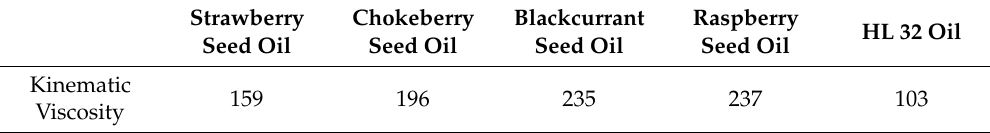
Table 2. Viscosity index of selected plant oils calculated at 40 ◦ C and 100 ◦